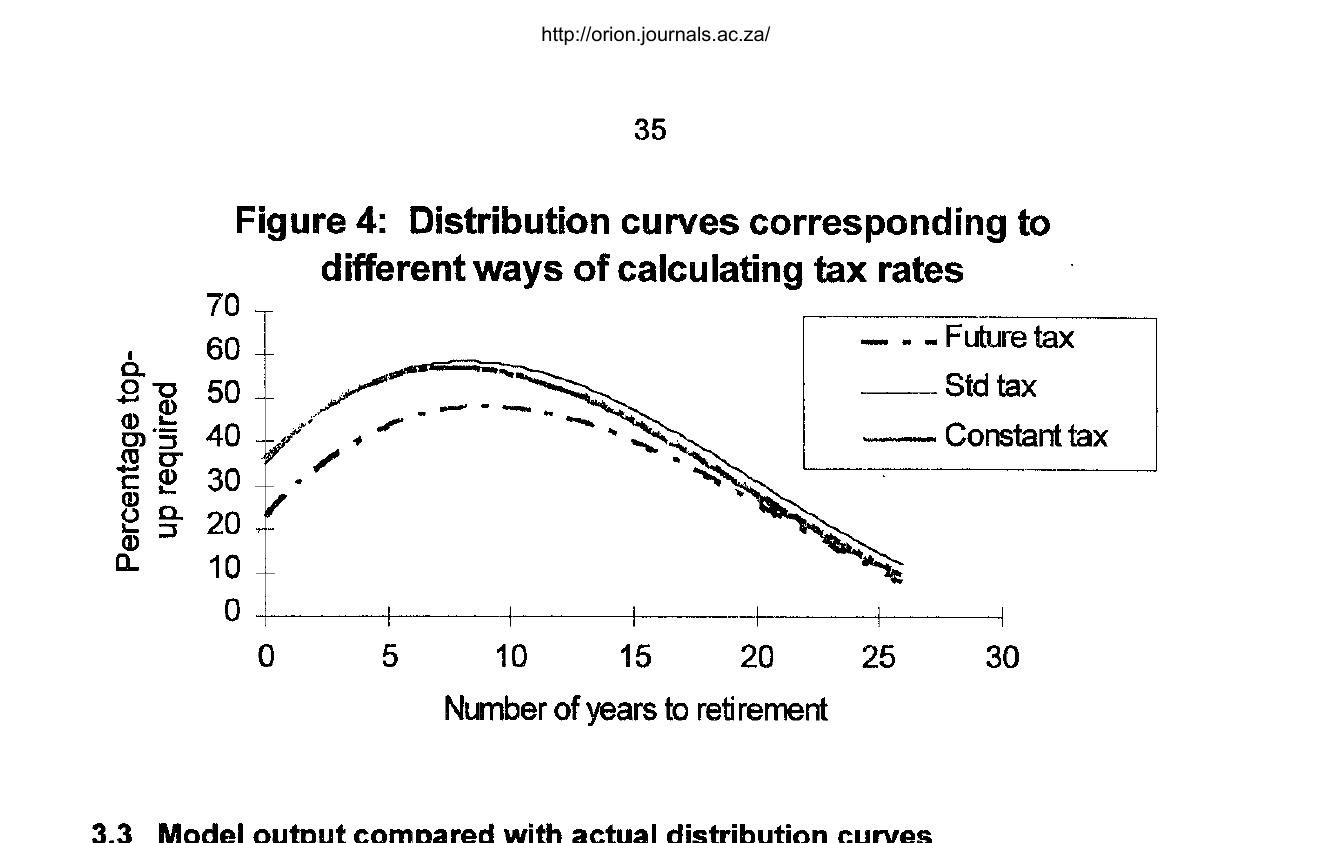
Figure 4: Distribution curves corresponding to different ways of calculating tax